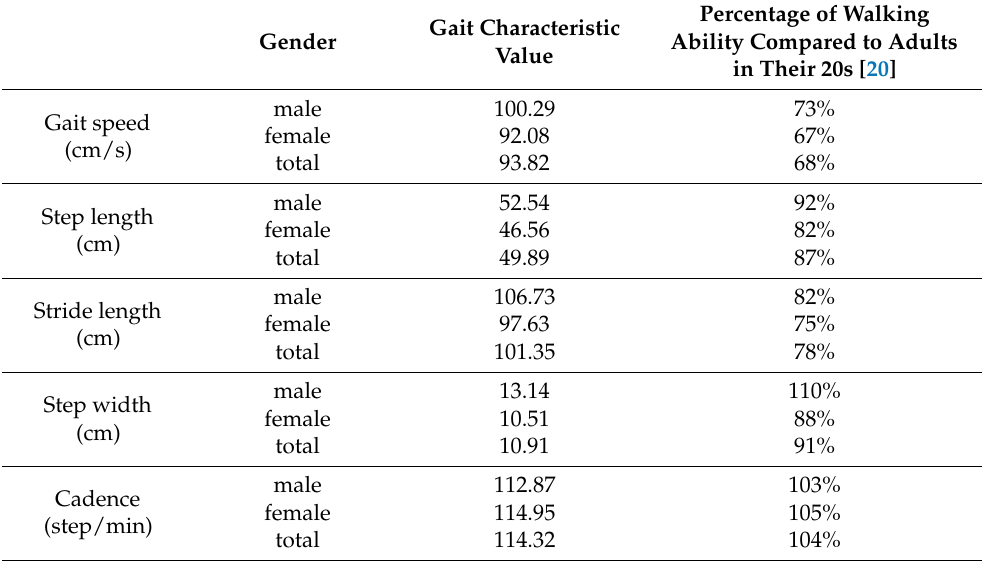
Table 9. Standard gait